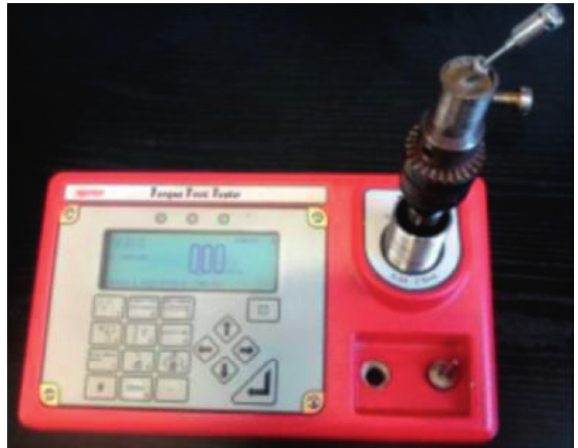
Figure 2: Digital torque gauge (torque tool tester, TST s´erie 2 Norbar ® , Navi Mumbai, India).